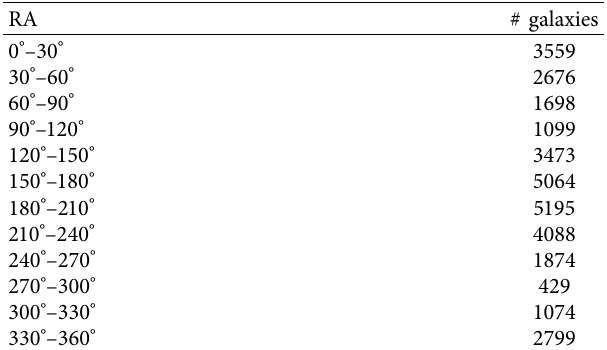
Table 5: The number of Pan-STARRS galaxies in different 30 o RA slices.